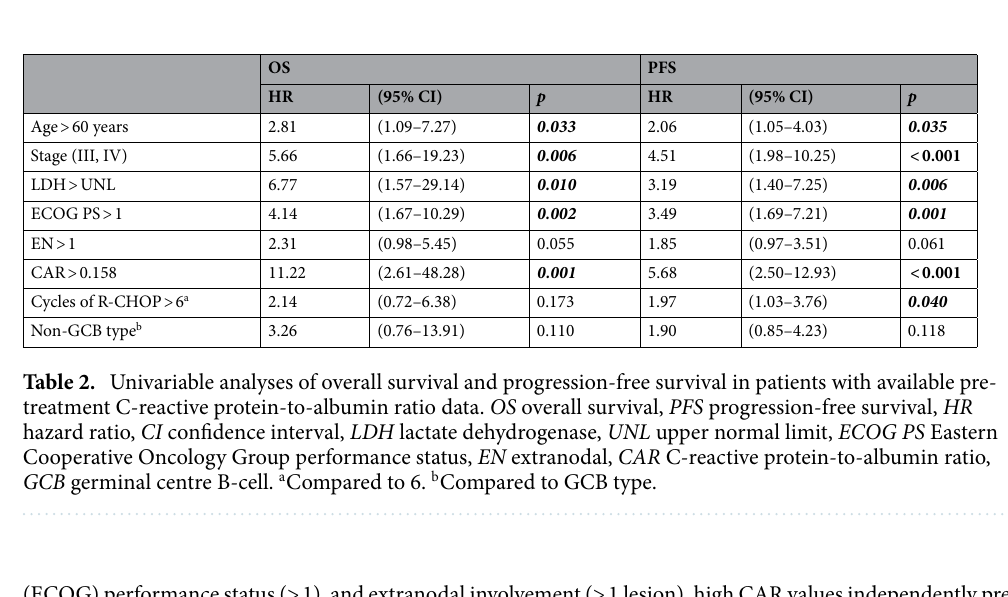
Figure 1. Kaplan–Meier curves for overall survival and progression-free survival according to the C-reactive protein-to-albumin ratio (CAR) at the diagnosis of diffuse large B-cell lymphoma.